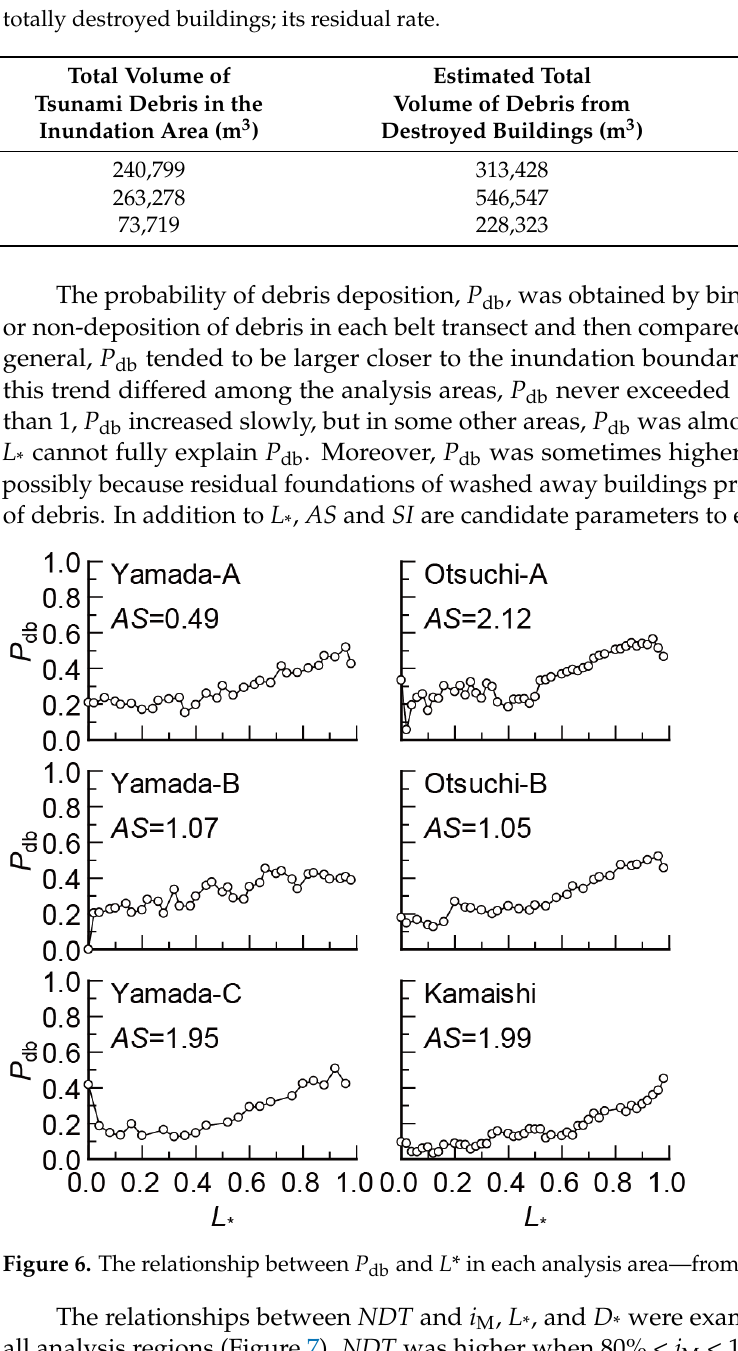
Figure 7. ( a ) Relationships among i M , L *, and NDT . ( b ) Relationships among i M , D *, and NDT . Each figure from Imai et al. [6].